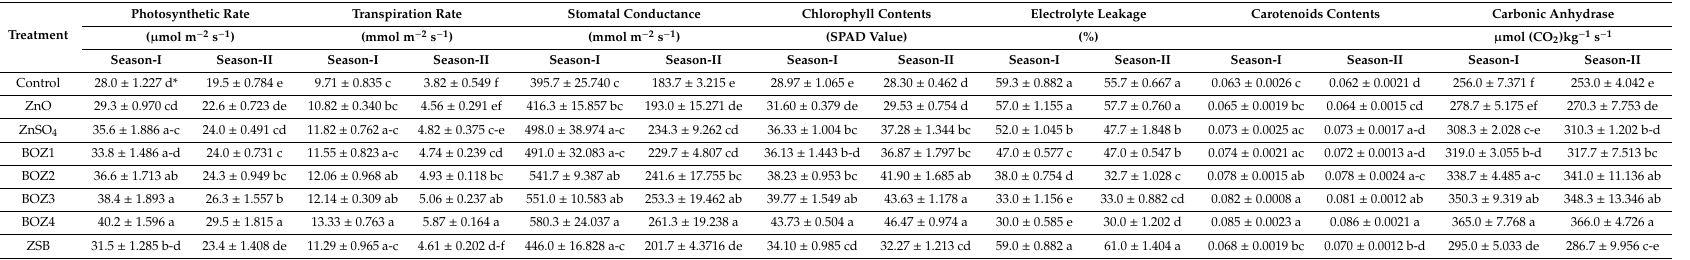
Table 4. E ff ect of di ff erent Zn sources on the physiology of maize grown in two di ff erent cropping